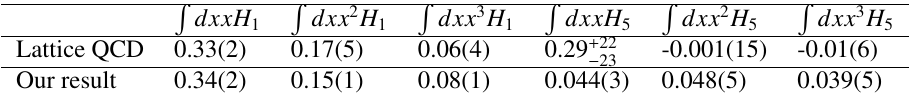
Table 1. Mellin moments of